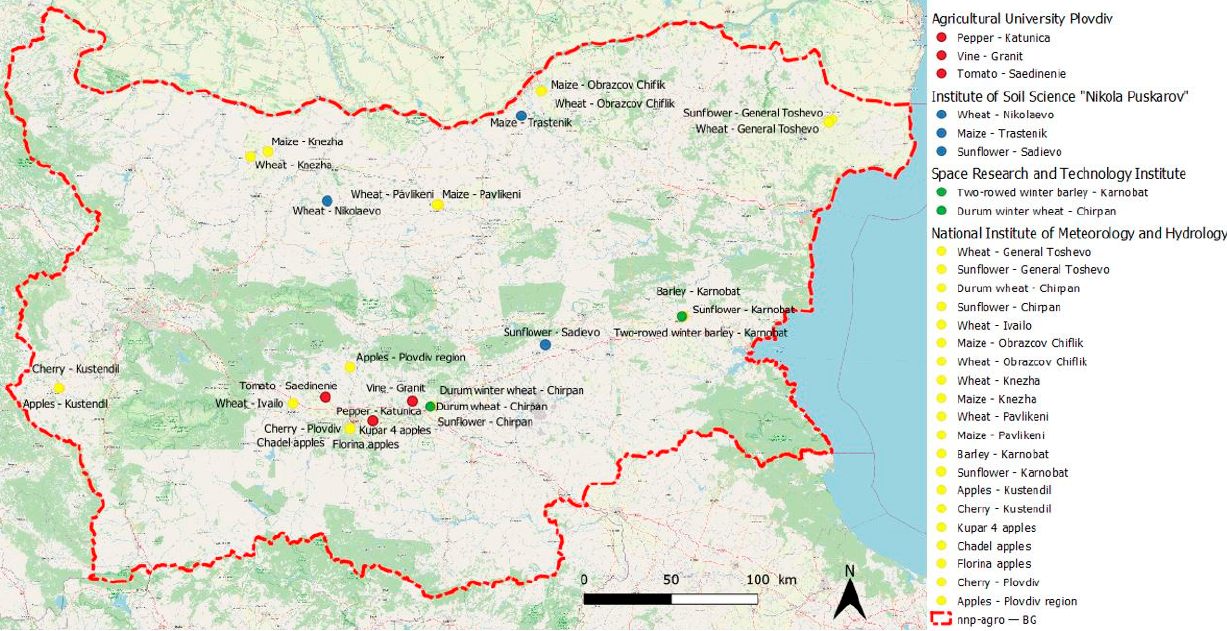
Figure 8. Pilot areas in Component 2 of the National Research Programme.